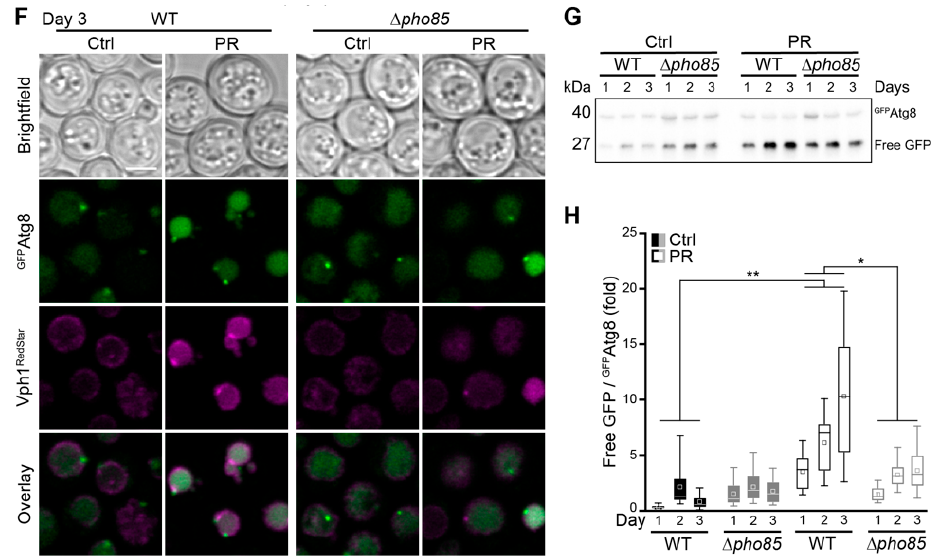
Figure 6. The cyclin-dependent kinase Pho85 is critical for phosphate exhaustion-induced autophagy. ( A ) Schematic representation of the yeast phosphate signaling (PHO) pathway. ( B–D ) Survival during chronological aging, determined via flow cytometric quantification of PI staining, of WT, ∆ rim15 and ∆ pho81 cells ( B ), and of WT, ∆ pho80 and ∆ pho85 cells ( C ) grown on Ctrl or PR media; n = 4. Corresponding median lifespan is shown in ( D ). ( E ) Median lifespan of WT and ∆ pho85 cells grown on Ctrl or nitrogen starvation (-N) medium; n = 4. ( F ) Confocal micrographs of WT and ∆ pho85 cells harboring GFP Atg8 and Vph1 RedStar (as vacuolar marker) at day 3 of aging on Ctrl or PR media. Scale bar represents 3 μ m. ( G , H ) Representative immunoblot ( G ) and corresponding densitometric quantification ( H ) of protein extracts from WT and ∆ pho85 cells harboring endogenously GFP-tagged Atg8 grown on Ctrl or PR medium. Blots were decorated with an antibody against GFP, and the ratio free GFP/ GFP Atg8 was plotted; n = 8. For statistical analysis, Welch–ANOVA with Dunnett T3 post hoc test ( D ) or a two-way ANOVA ( H ) was used. * p < 0.05, ** p < 0.01 and *** p < 0.001.